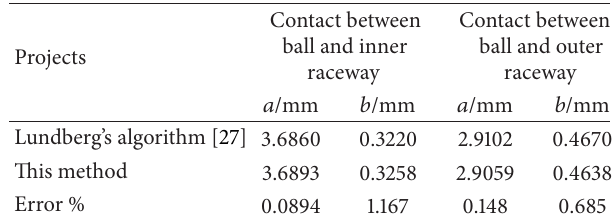
Table 2: Contact area size.